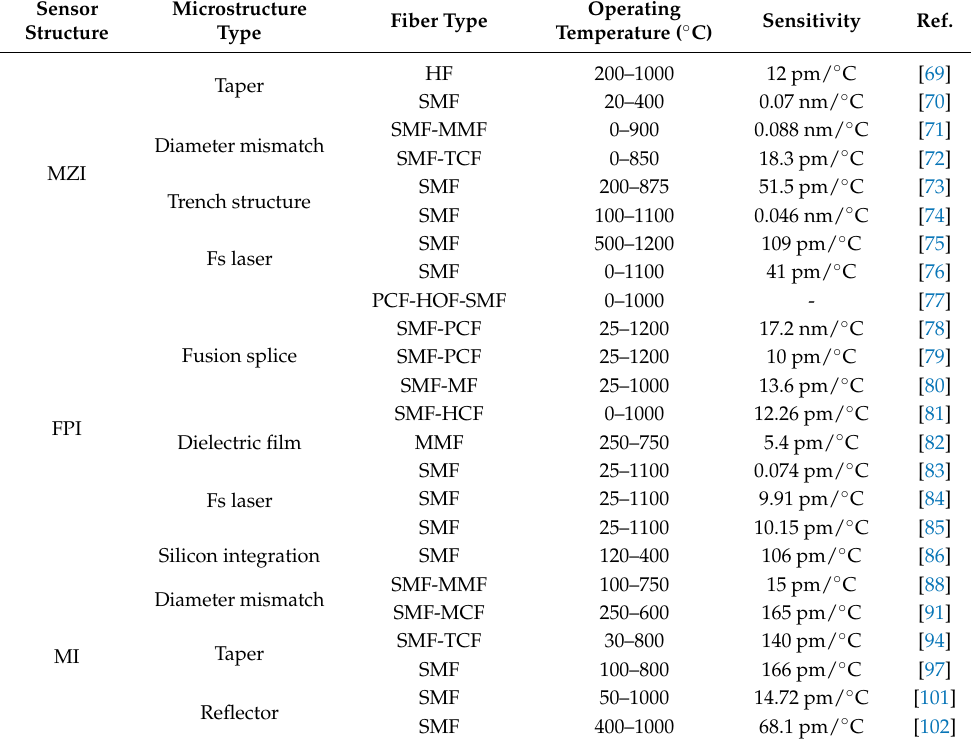
Table 3. Comparison of micro-structured fiber-optic interference sensors based on silica